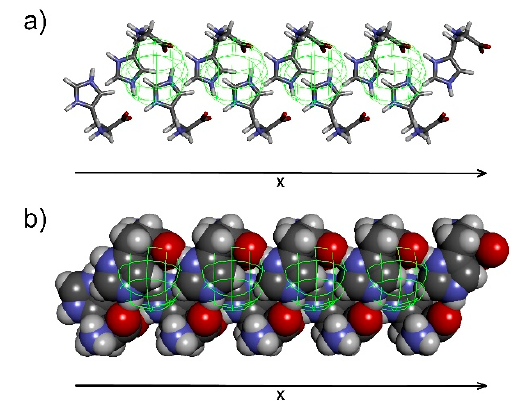
Figure 7. Visualization of 2.90 Å spheres around hydrogen H8 in the molecular chain; ( a ) stick presentation, ( b ) space fill